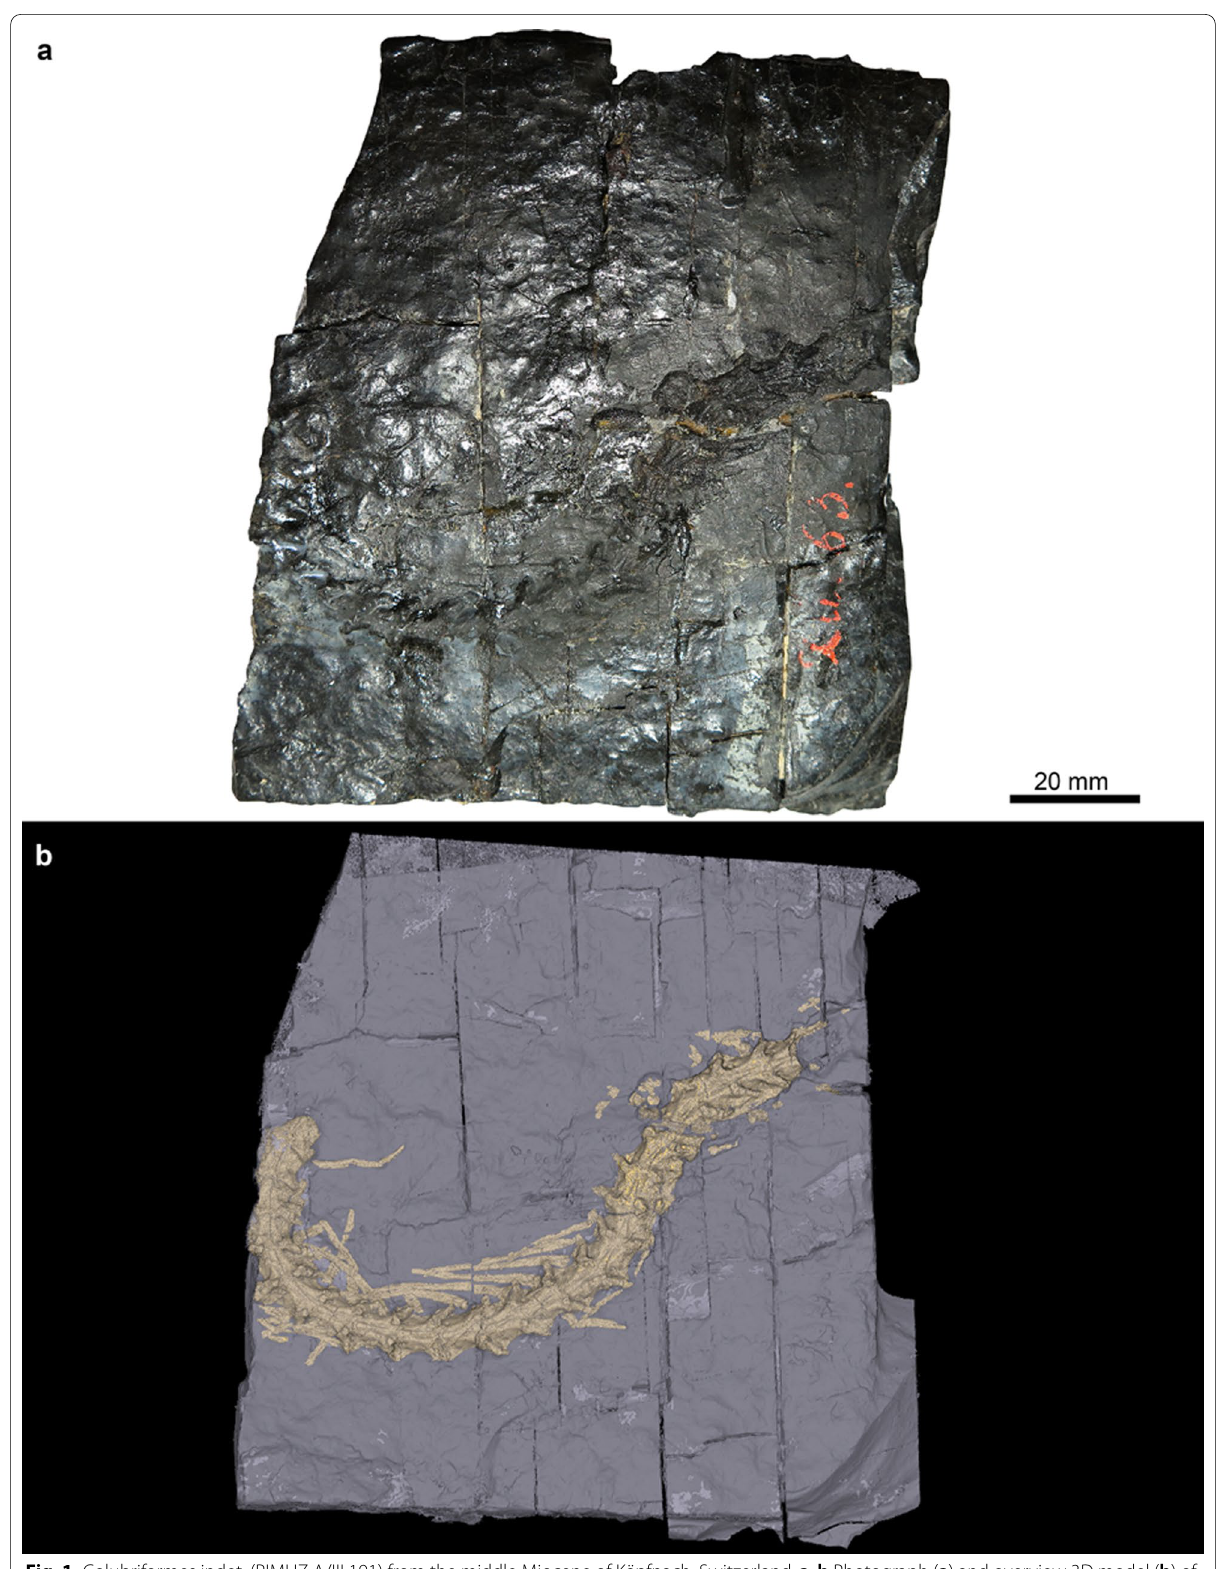
Fig. 1 Colubriformes indet. (PIMUZ A/III 191) from the middle Miocene of Käpfnach, Switzerland. a , b Photograph ( a ) and overview 3D model ( b ) of the fossil skeleton on the